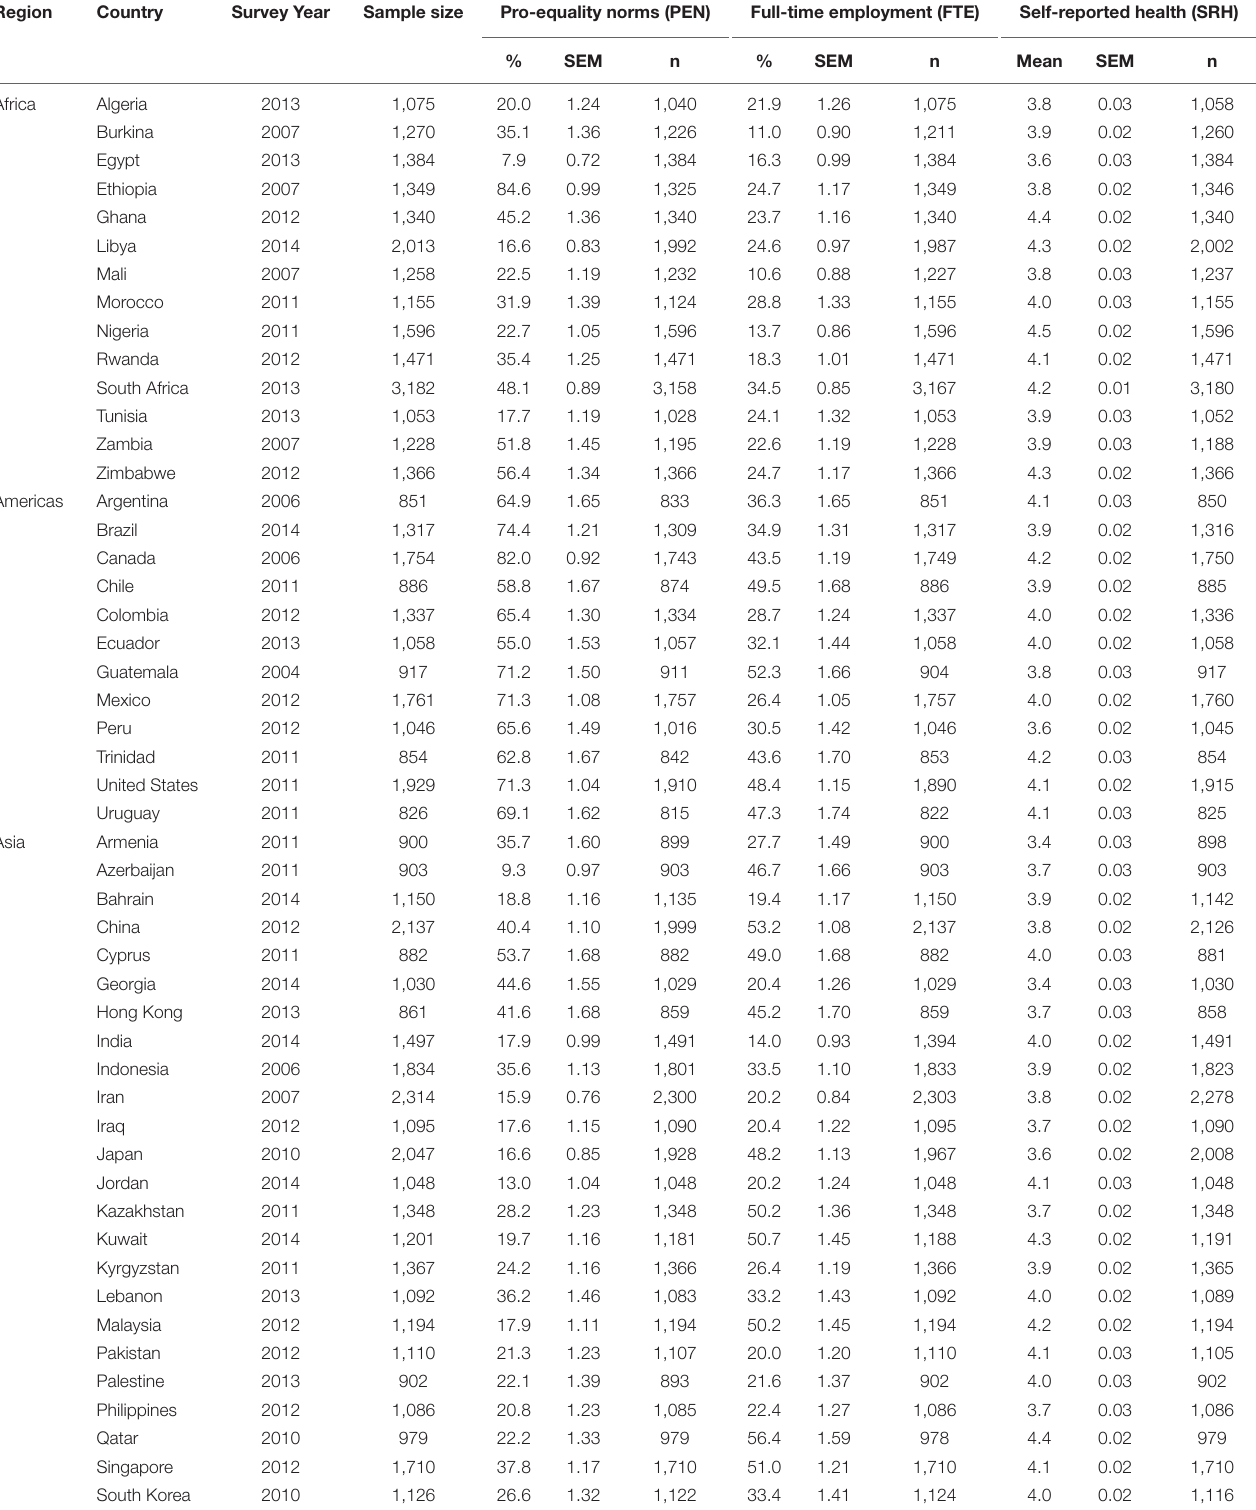
TABLE 1 | Pro-equality norms, full-time employment and self-reported health in 97 countries (men and women combined). Region Country Survey Year Sample size Pro-equality norms (PEN) Full-time employment (FTE) Self-reported health (SRH) % SEM n % SEM n